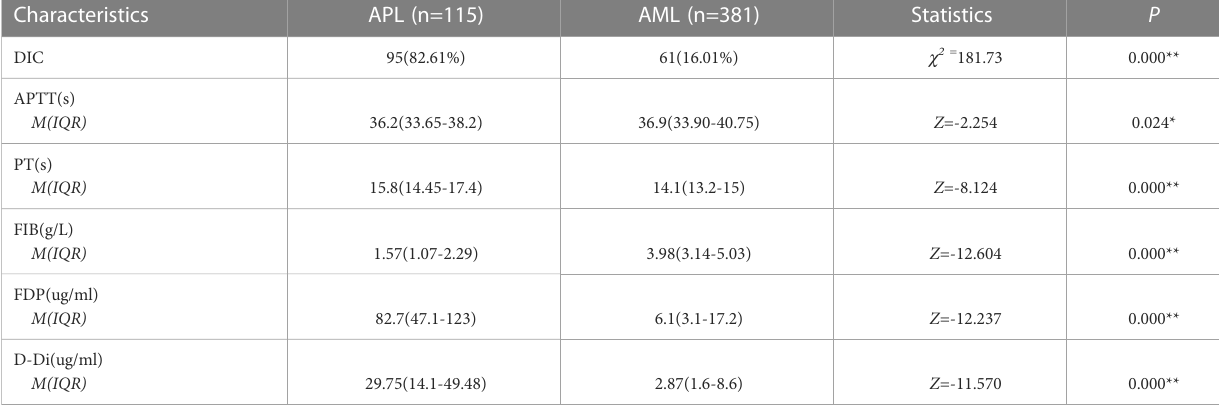
TABLE 2 Comparison of coagulation function between newly diagnosed APL and AML (non-APL) patients.